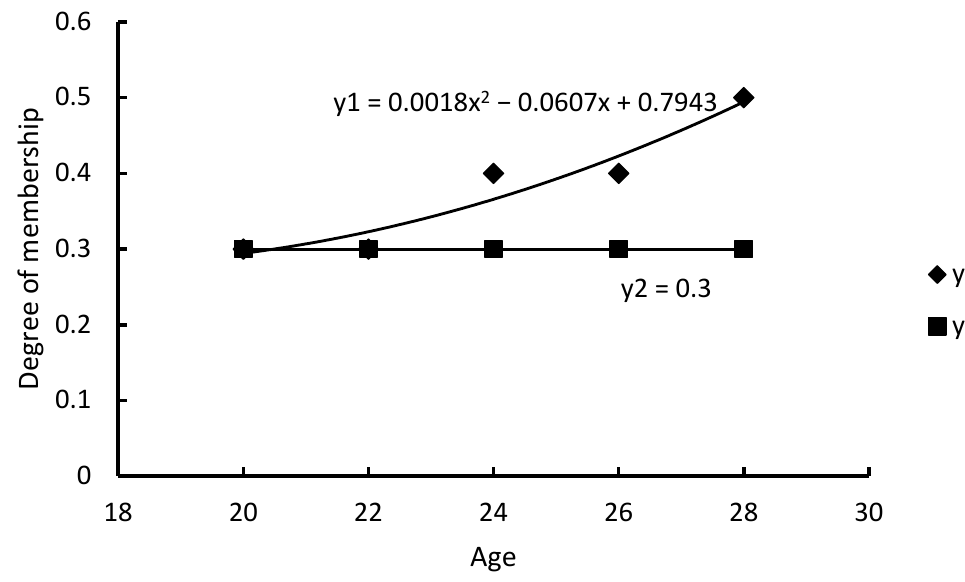
Figure 3. Single factor evaluation for 19–30 years old. In the interval of 31–50 years old, the fitting results of y 1 and y 2 are shown in Figure 4, where y 1 = − 0.012 x + 0.98, y 2 = − 0.0009 x 2 + 0.0746 x − 1.2686. Then y 3 = 0.0009 x 2 − 0.0626 x + 1.2886 is calculated by Equation (7).